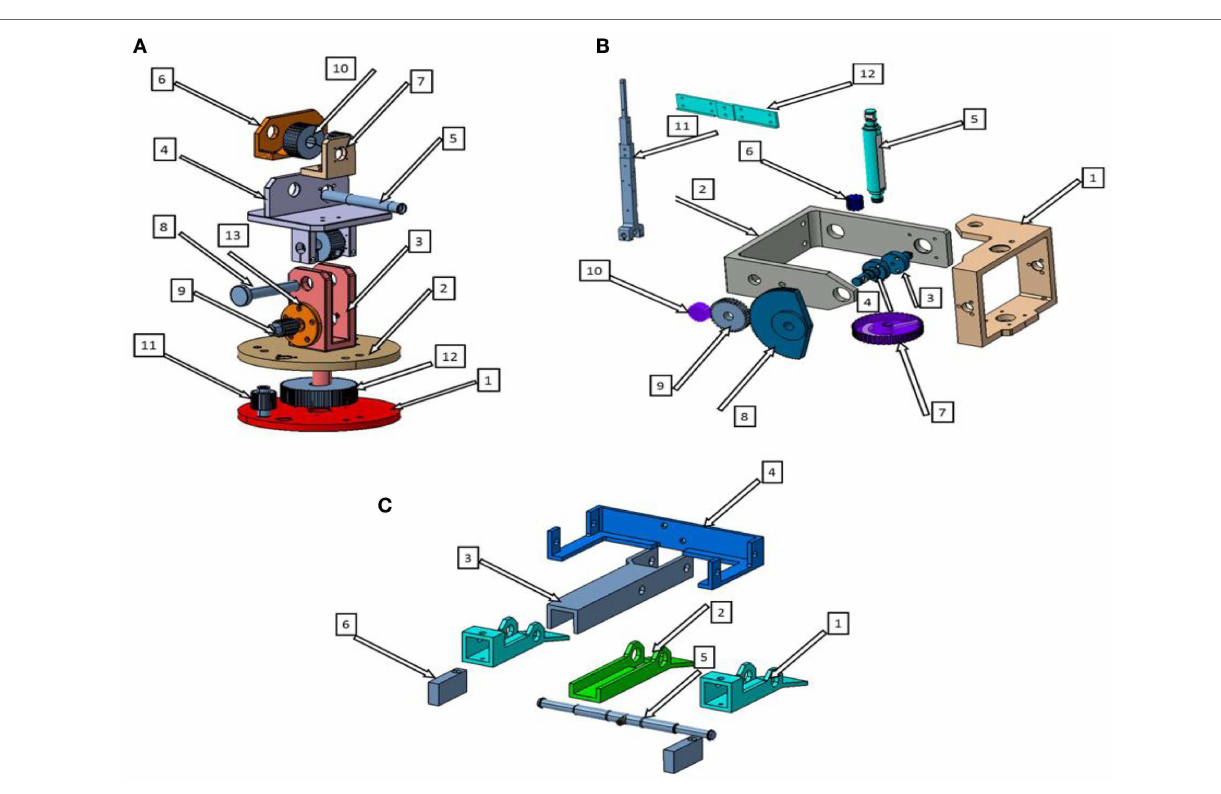
Fr ontiers in Robotics and AI |